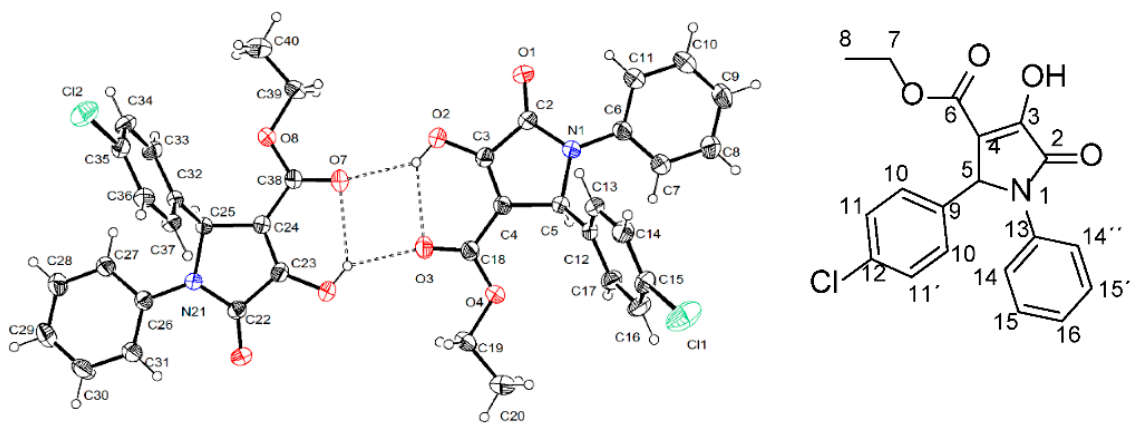
Figure 7. Stereo structure of DEXT-2 determined by X-ray crystallographic analysis.